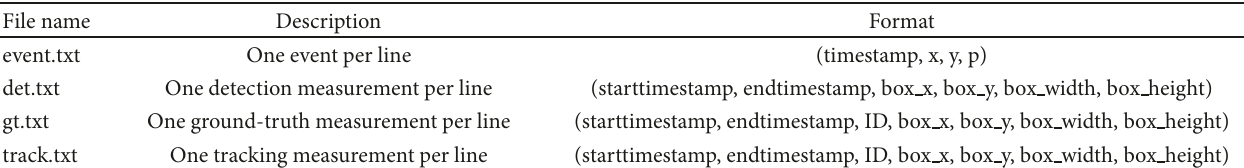
Table 1: The standard file format in our benchmark. In event.txt, timestamp recodes the timestamp of each raw event, x and y are the coordinates of the event’s origin, and p is the event’s polarity. In det.txt, box x and box y are x and y coordinates of the bounding box and box width and box height are the width and height of each bounding box. The events which fall into a bounding box from start timestamp to end timestamp are accumulated to a cluster. Each cluster has an ID. The items’ definitions in gt.txt and track.txt are similar to det.txt file, except that the gt.txt shows the ground truth and track.txt shows the result of